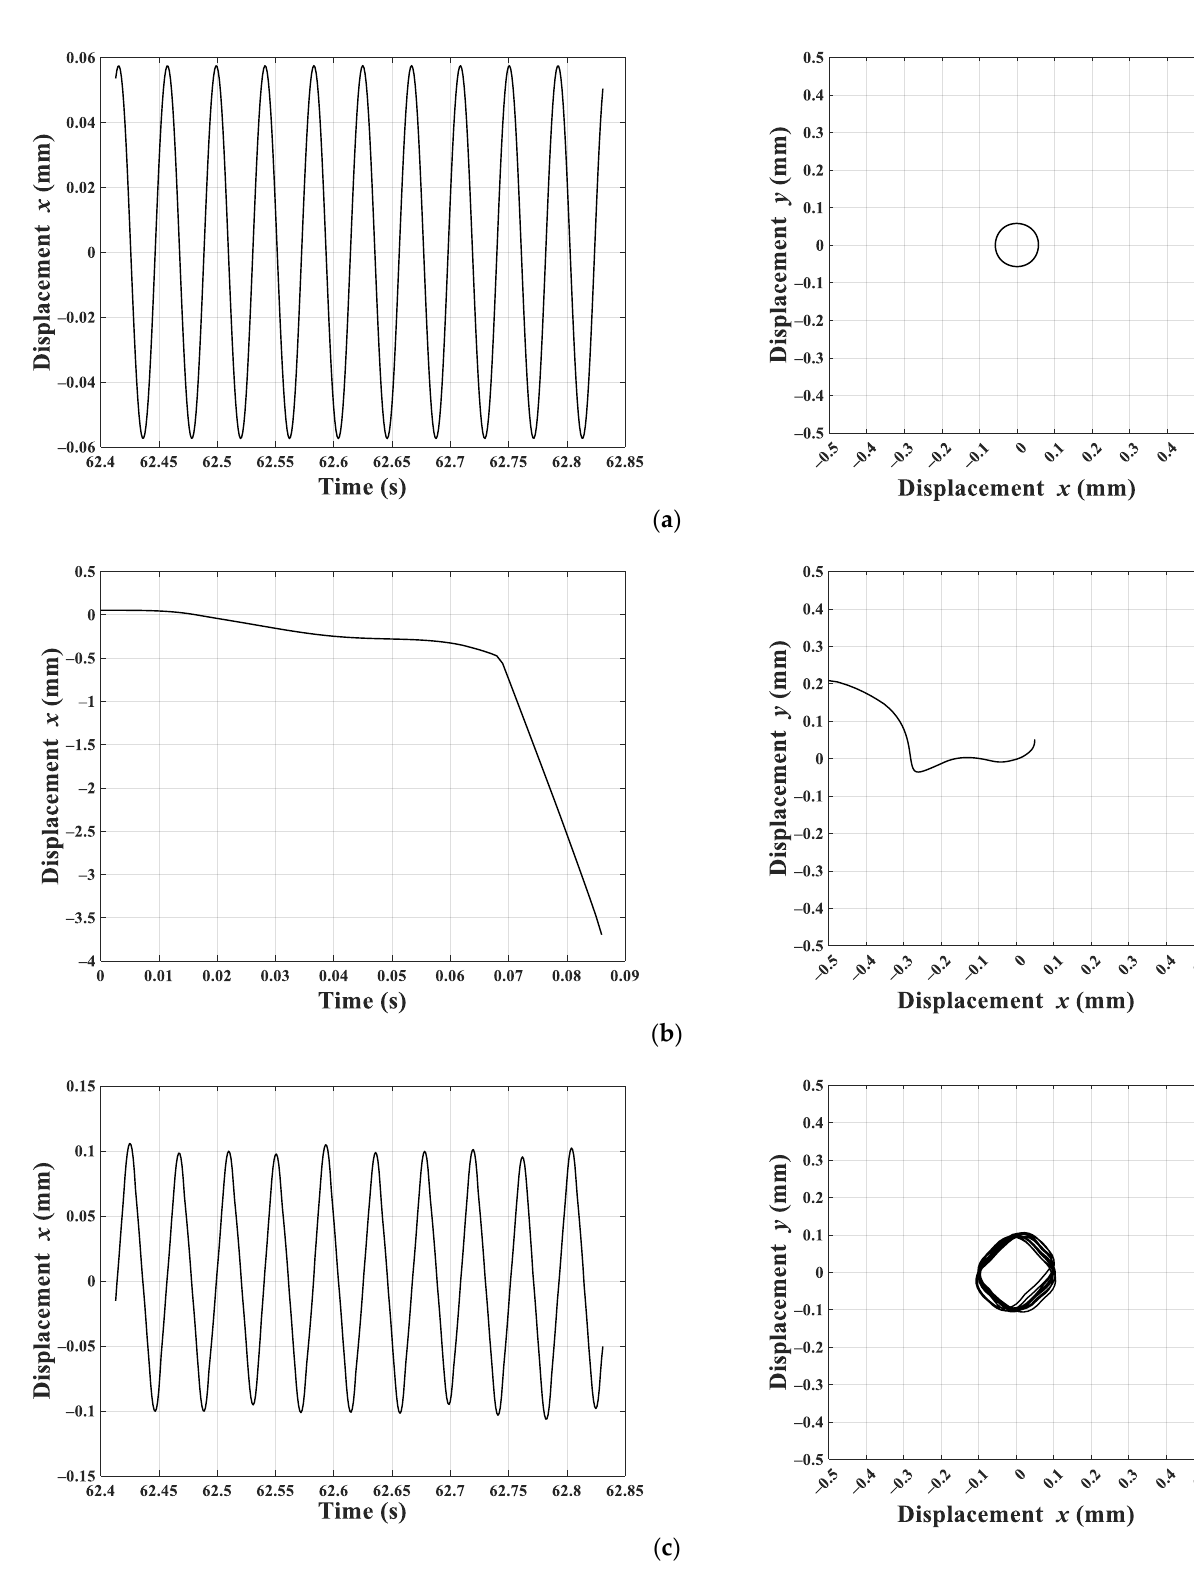
Figure 7. Last 10 cycles of rotor response for ρ = 0.04 mm, ω = 150 rad/s, x 0 = y 0 = 0.05 mm: ( a ) PD controller, ( b ) FLC, ( c ) FBBRC.